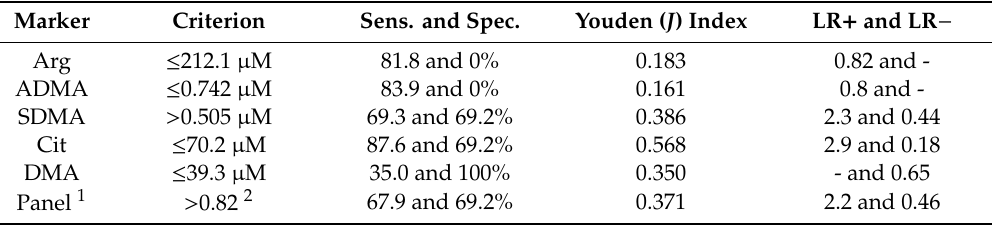
Table 8. Characteristics of L-arginine / NO pathway metabolites as biomarkers for CRC surveillance in inflammatory bowel disease (IBD)